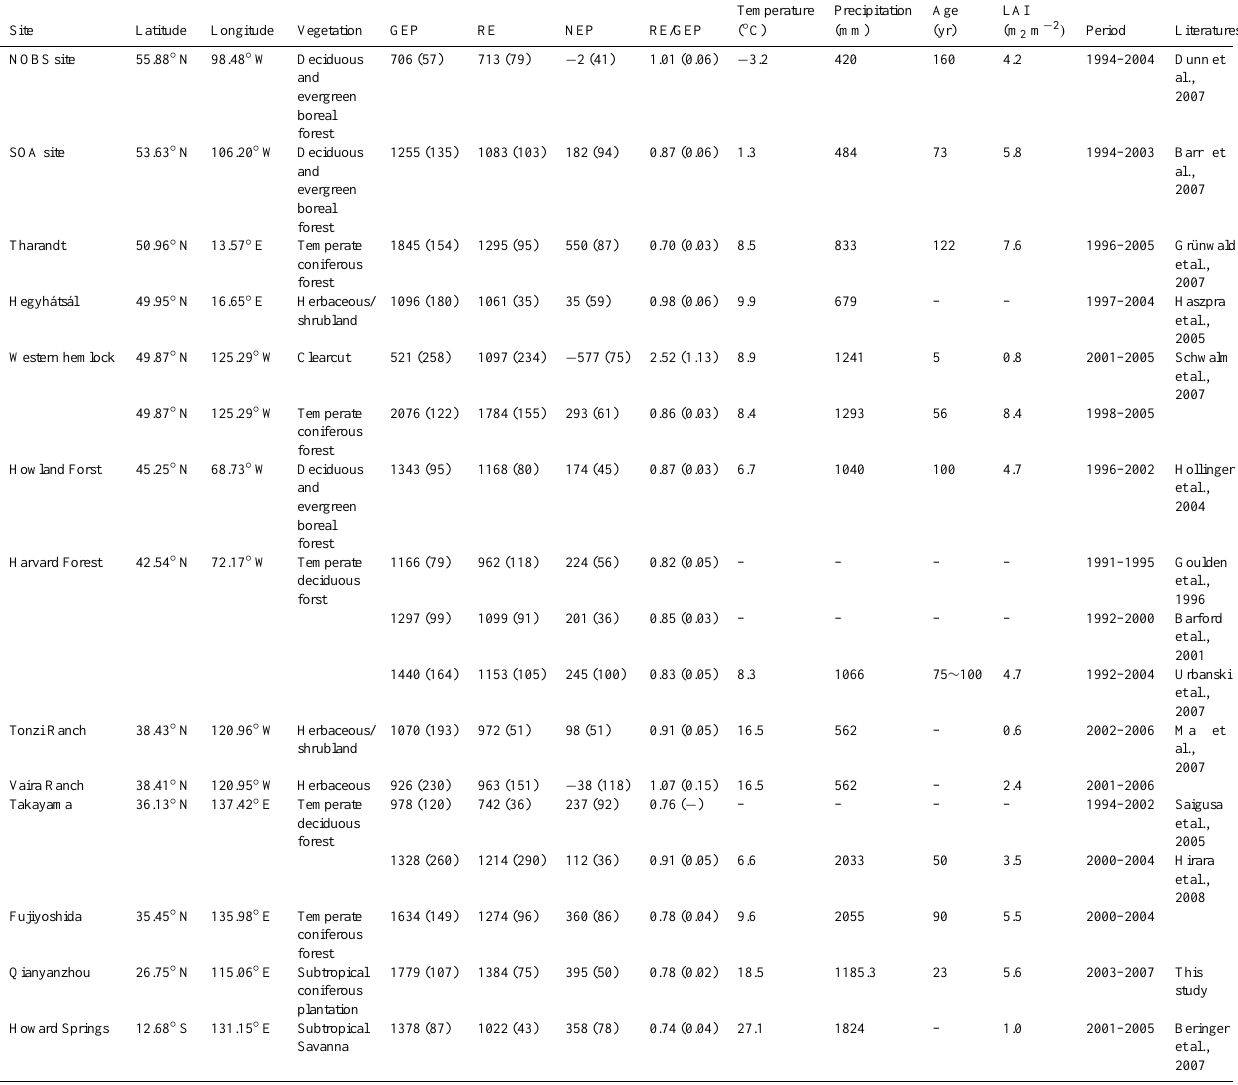
Table 3. Comparison of ecosystem carbon exchanges (gCm − 2 yr − 1 ) among different ecosystems with at least 5 years records. The values in the bracket indicate the standard